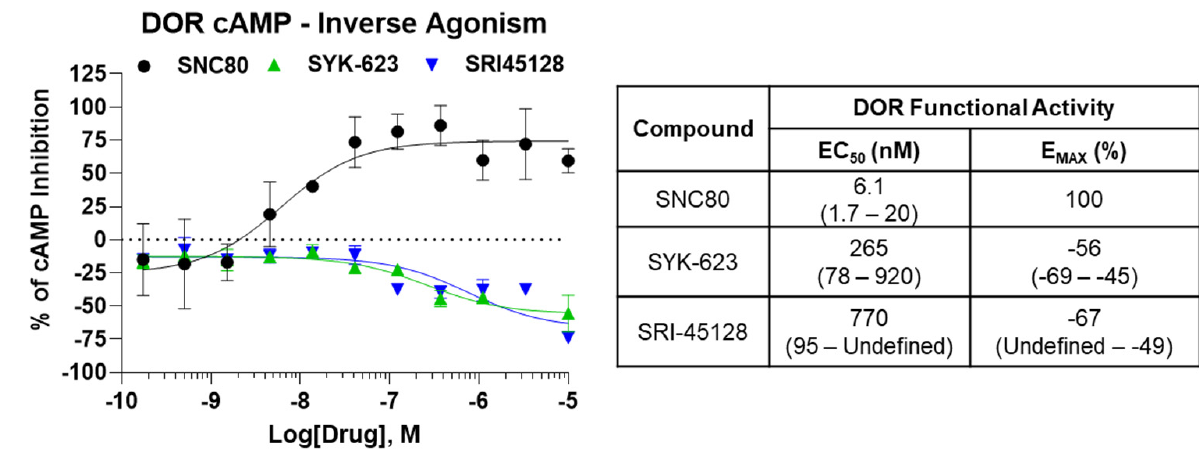
Figure 3. SRI-45128 caused DOR inverse agonist activity. SRI-45128, positive control SYK-623, and SNC80 reference compounds were used to modulate the cAMP accumulation caused by forskolin treatment (see Methods). One independent experiment in triplicate was performed, and the potency (EC 50 ) and efficacy (E MAX ) were reported as the derived value with 95% confidence intervals (in parentheses). As expected, SNC80 caused high potency and efficacy cAMP inhibition, which is consistent with DOR agonist activity. SRI-45128 and SYK-623 caused efficacious cAMP increases, which is contrary to DOR agonism and consistent with DOR inverse